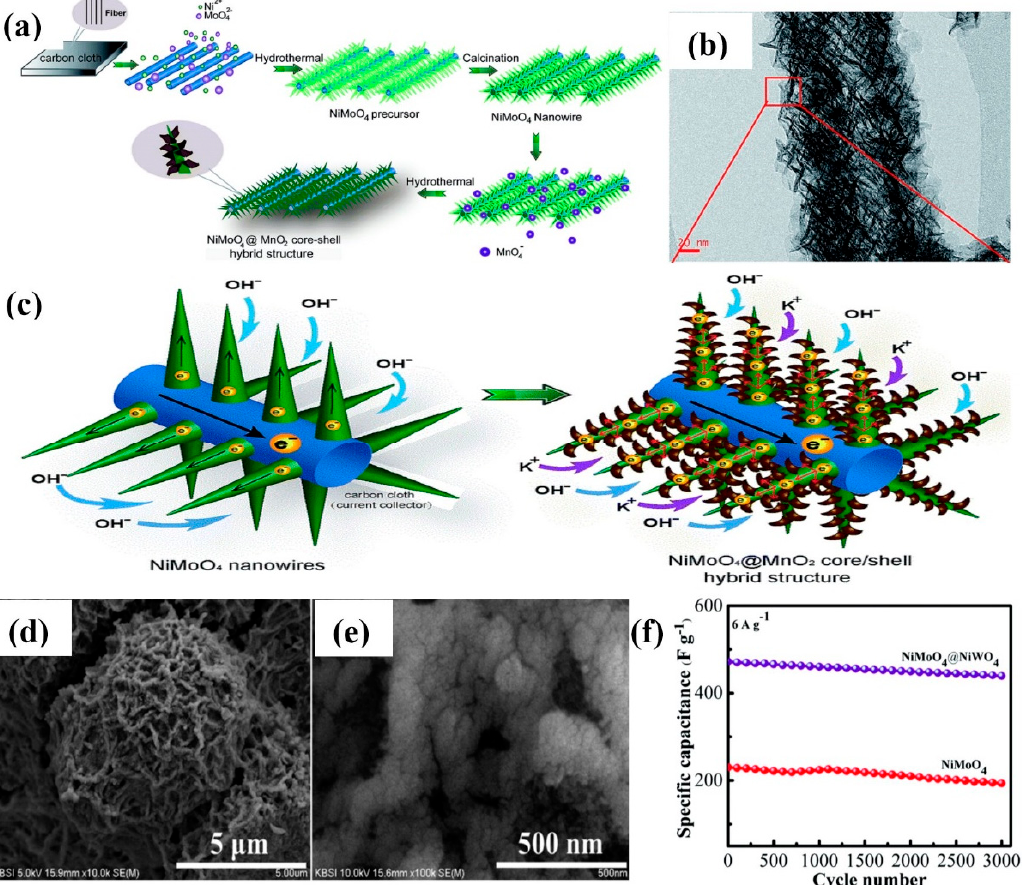
Figure 3. ( a ) Schematic diagram of the fabrication process of NiMoO 4 − MnO 2 core − shell hybrid struc- ture, ( b ) TEM image of NiMoO 4 − MnO 2 scratched from CC, ( c ) Schematic diagram showing